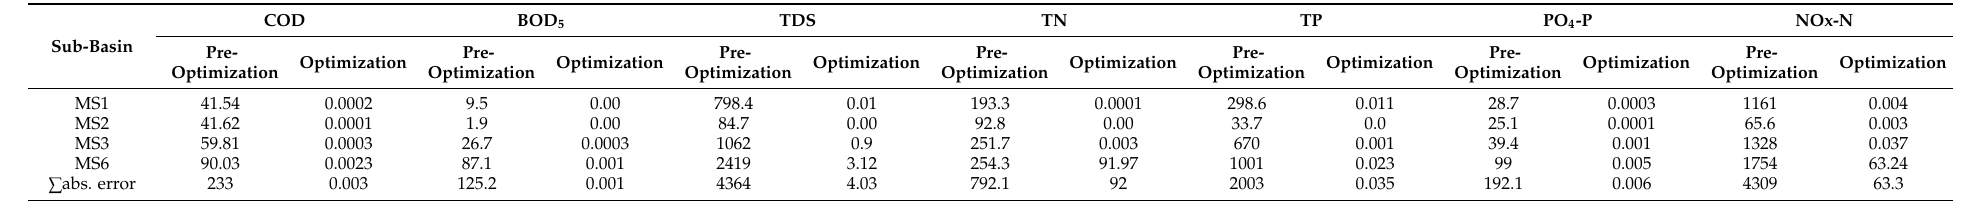
Table 8. The total percentage error between measured and simulated load at the initial stage of calibration/pre-optimization and after optimization in all monitoring stations in